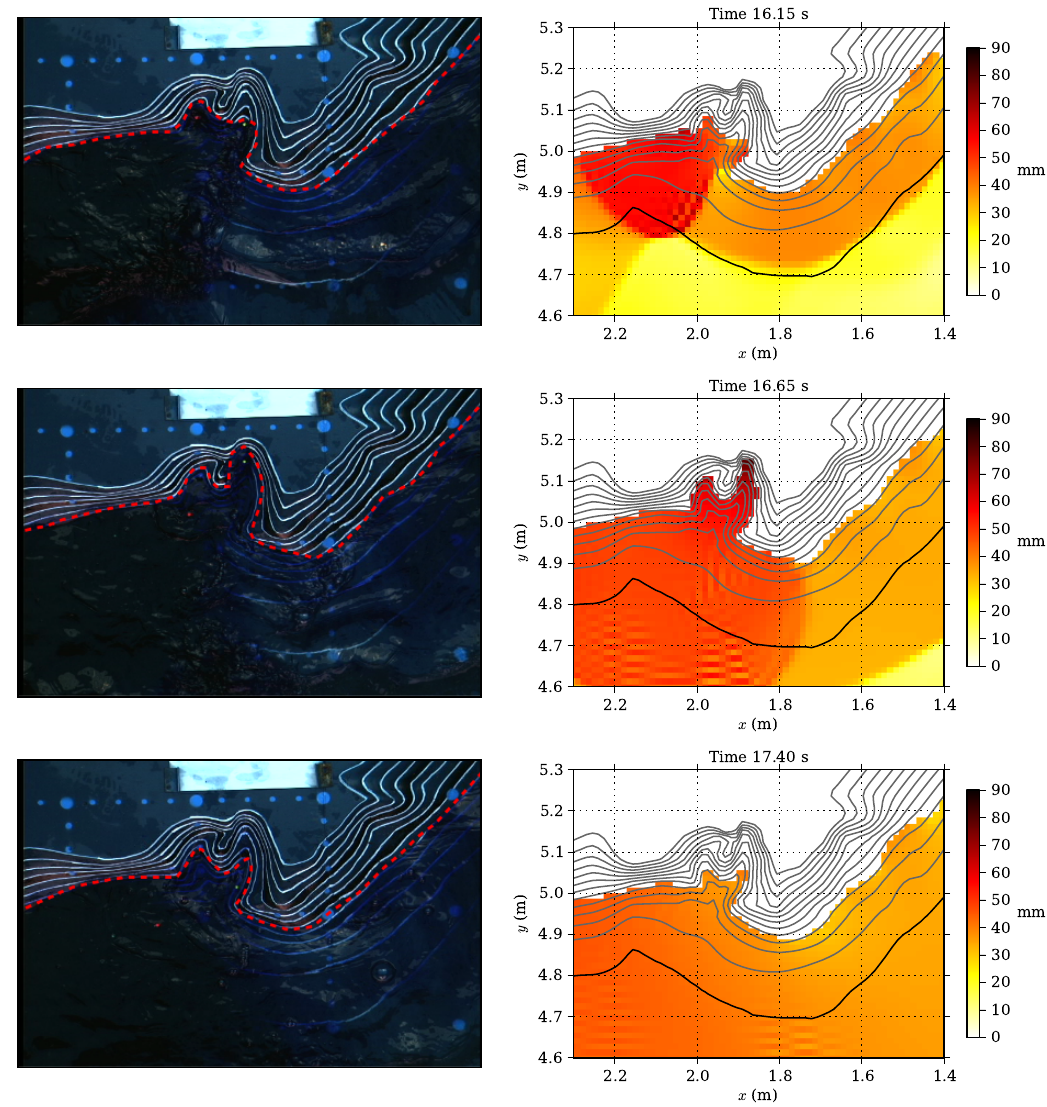
Fig. 19. Benchmark n. 4: snapshot comparison. Images on the left column have been extracted by the movie recorded during the experiment (Matsuyama and Tanaka, 2001). Movie frames are separated by 0.05s and here we have selected the numbers 45, 55 and 70. On the right column the corresponding calculated snapshot with the same time separation are given. We have assumed that frame 45 corresponds to the time 16.15s of simulation. Space coordinates are the same as in the computational grid. Topography contour lines are at 1cm